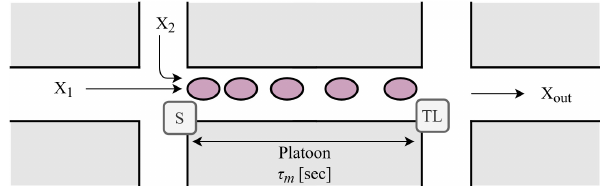
Figure 2. Road segment